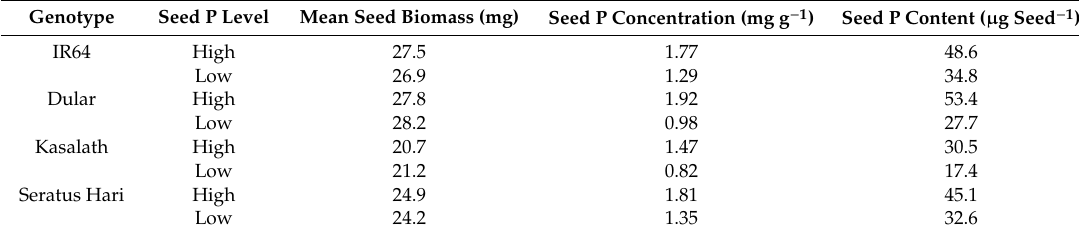
Table 1. Mean biomass, P concentration and P content of low- and high-phosphorus seeds used in all